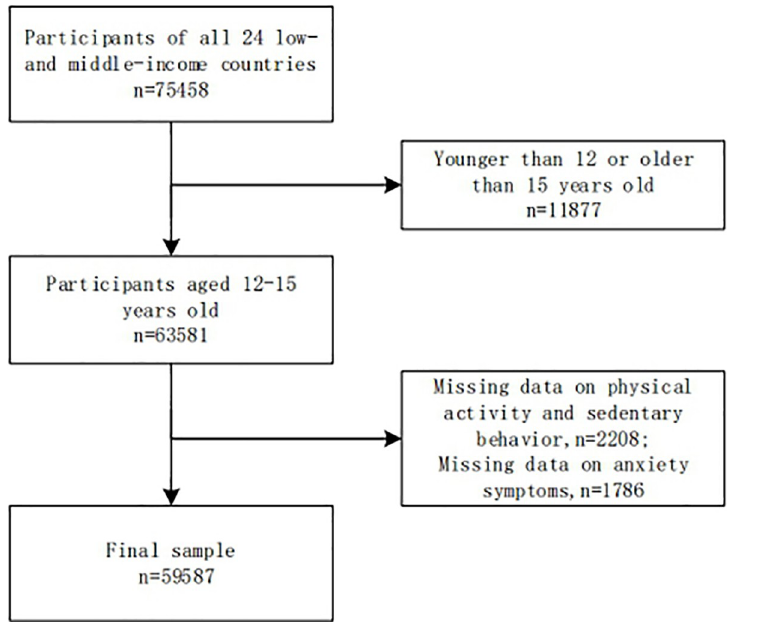
Fig 1. Flow chart of the study